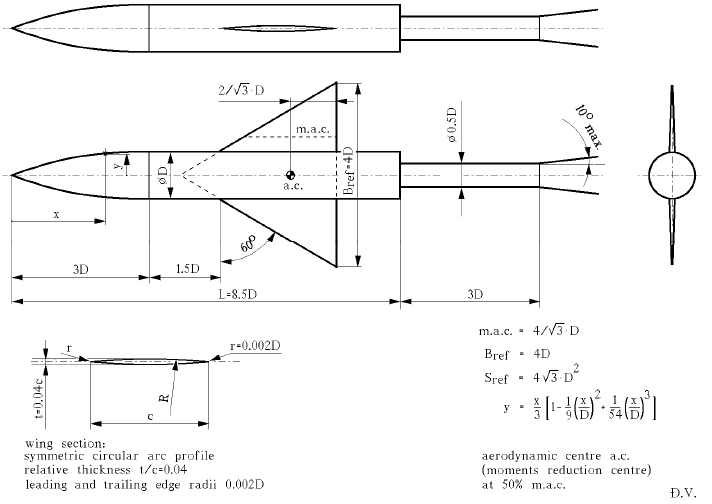
Figure 6. Theoretical geometry of AGARD-B standard model with dimensions given in terms of body diameter, based on [34–36].